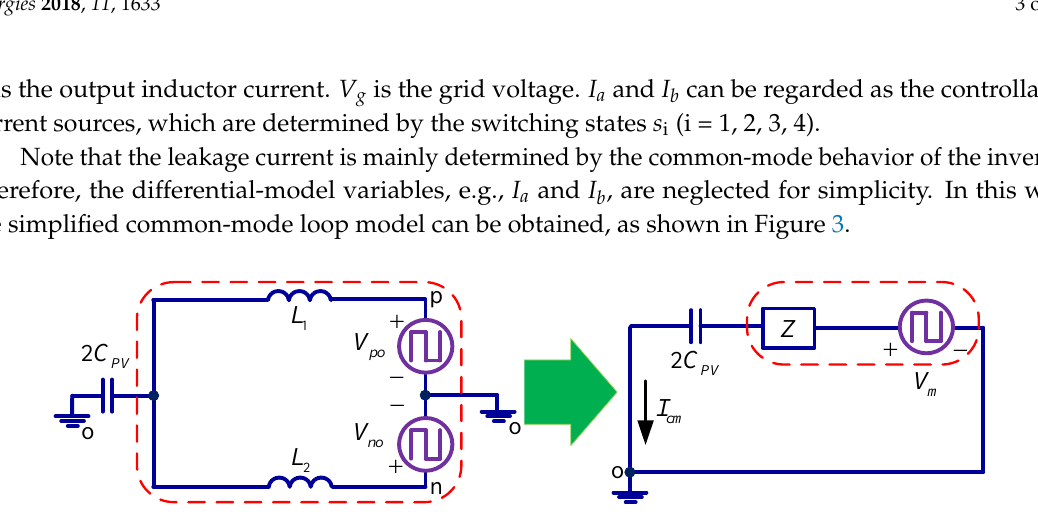
Figure 3. Simplified common-mode model of the CH4 inverter.